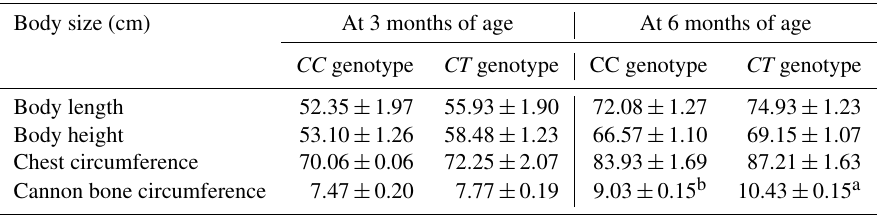
Table A6. Least-squares analysis of body size parameters of three-way crossbred lambs with different genotypes at 3 and 6 months of age (least-squares mean ± standard